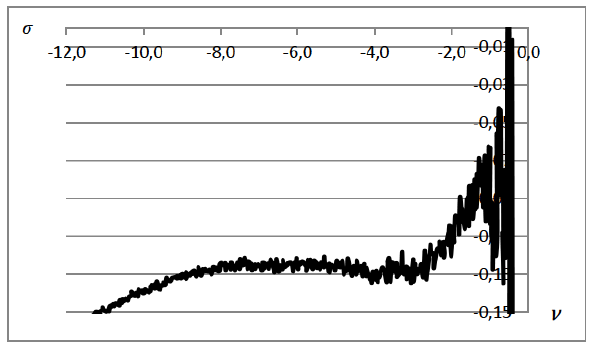
Figure 10: The dependence of the σ stress from the quotient of transverse to longitudinal deformation ν in the cement adhesive C2S1.